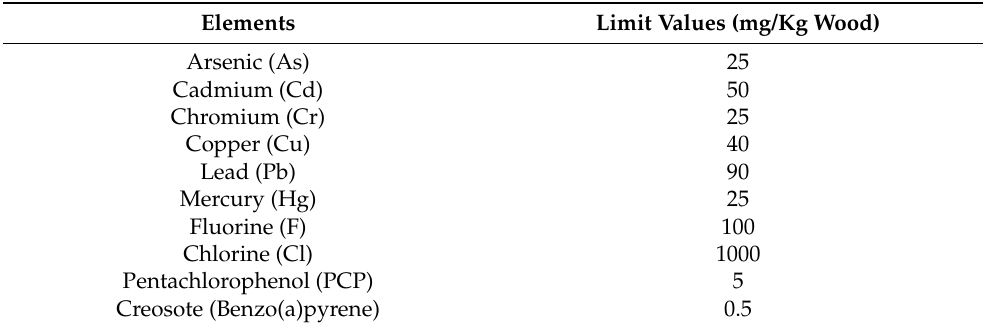
Table 2. Limit thresholds of contamination of recycled wood for panel production and of the panels themselves